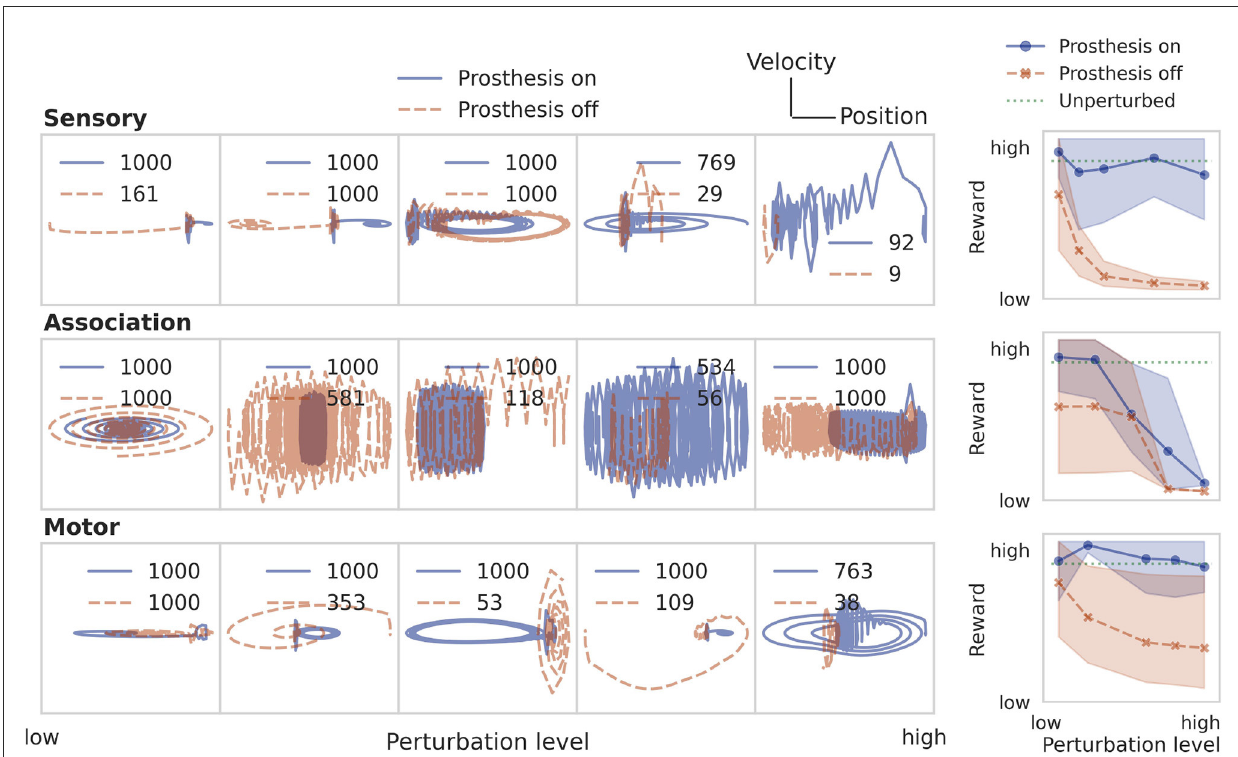
FIGURE7 Restoring performance of the neural system on the pole balancing task by training a prosthetic controller using RL. See caption of Figure 5 for a more detailed description.